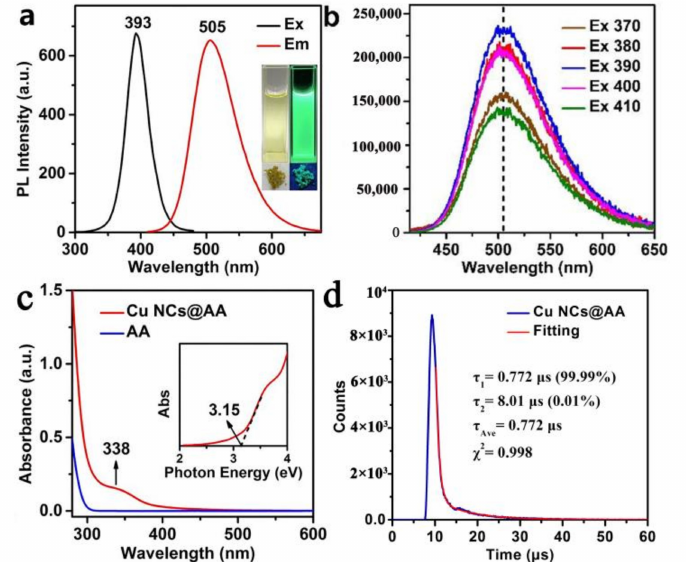
Figure 1. ( a ) The optimal excitation and emission spectra of the as-prepared aqueous Cu NCs@AA, and the inset is photographs of Cu NCs@AA under daylight (left) and UV light (right) at 365 nm irradiation. ( b ) Emission spectra of the as-prepared Cu NCs@AA under various excitation wavelengths. ( c ) UV-vis absorption spectra of Cu NCs@AA and AA, and the inset shows the absorption spectrum of Cu NCs@AA plotted on an energy (eV) axis as well. ( d ) Fluorescence decay profile of Cu NCs@AA (excitation: 393 nm; emission monitored at 505 nm). The amplitude-weighted average lifetime τ Ave = 0.772 µ